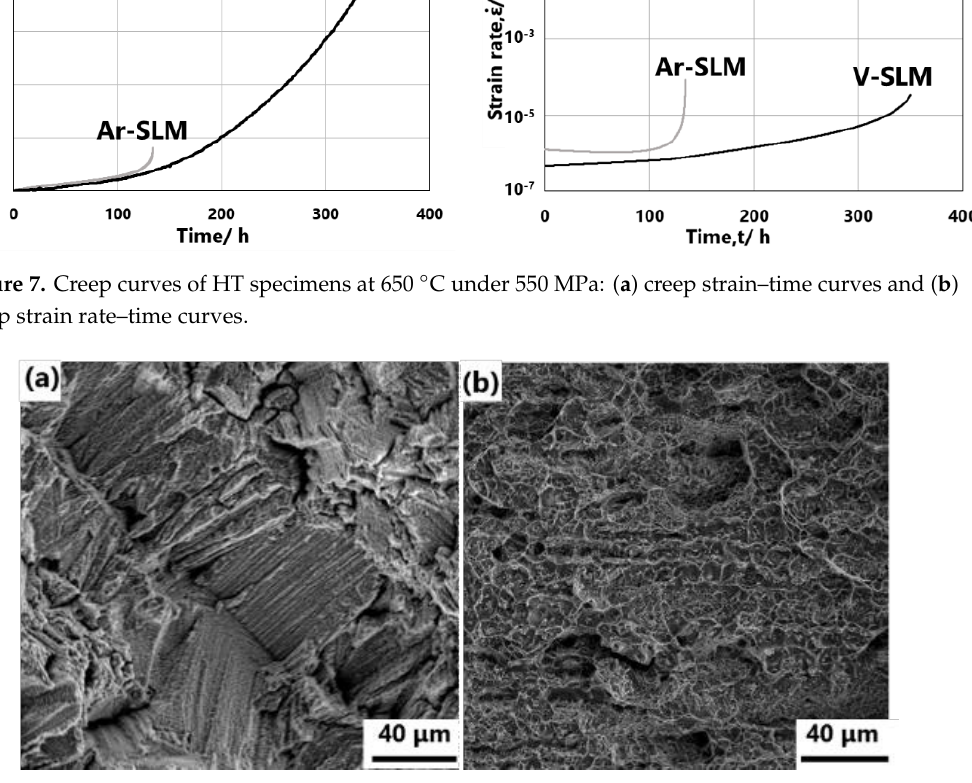
Figure 8. Rupture surfaces of: ( a ) Ar-SLM [11], and ( b ) V-SLM specimens, after creep tests at 650 ◦ C under 550 MPa. © 2017